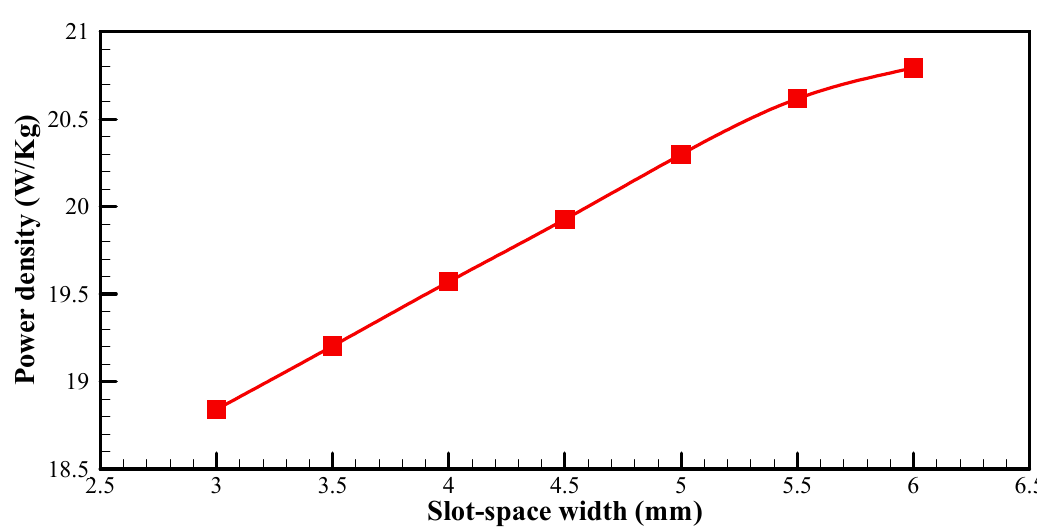
Figure 15. Influence of slot-spacing on power density.